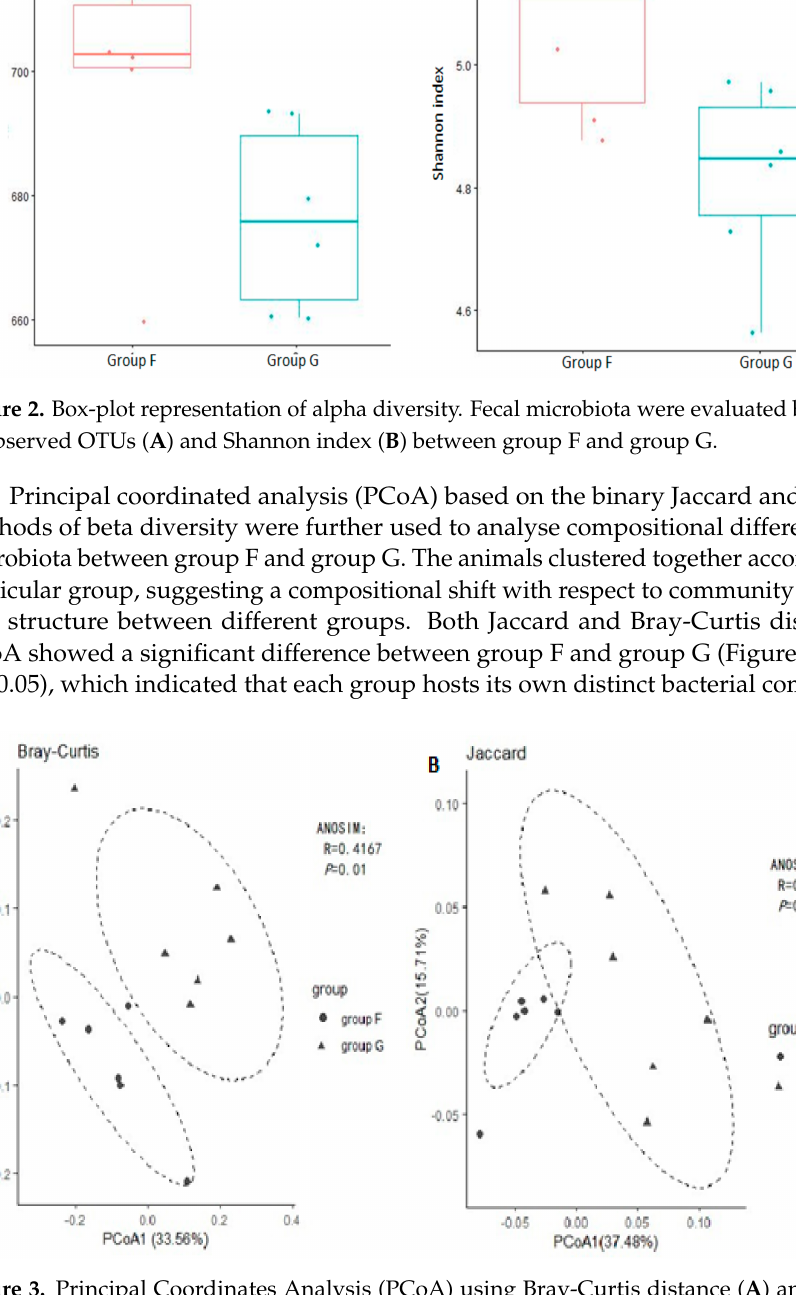
Figure 3. Principal Coordinates Analysis (PCoA) using Bray-Curtis distance ( A ) and Jaccard dis- tance ( B